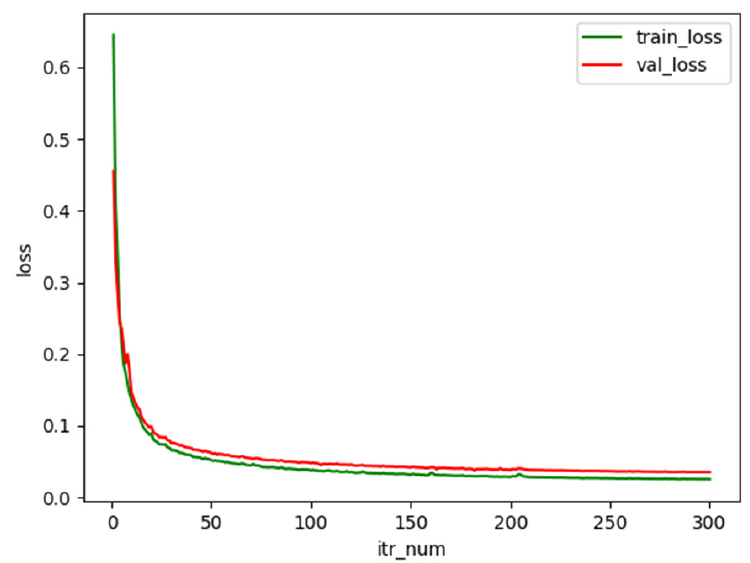
Figure 9. Lovasz Softmax loss function change curve.